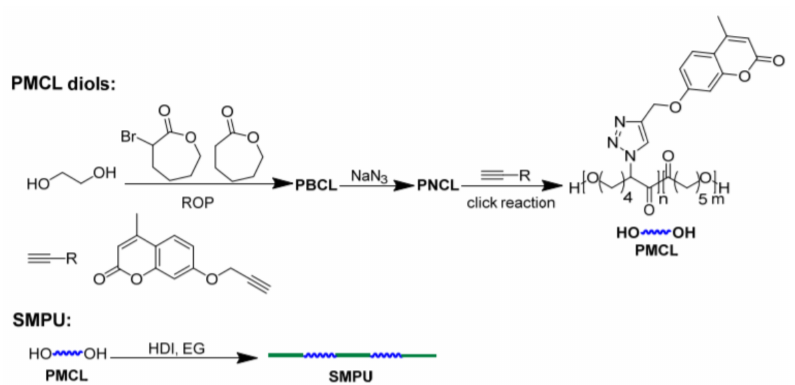
Figure 39. Synthetic route of shape-memory polyurethanes (SMPU) containing coumarin moieties. Reprinted from [202], Copyright (2019), with permission from